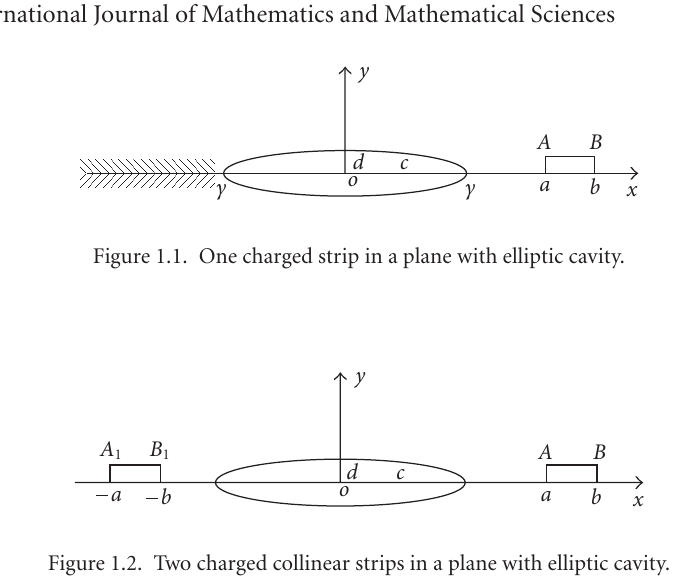
Figure 1.2. Two charged collinear strips in a plane with elliptic